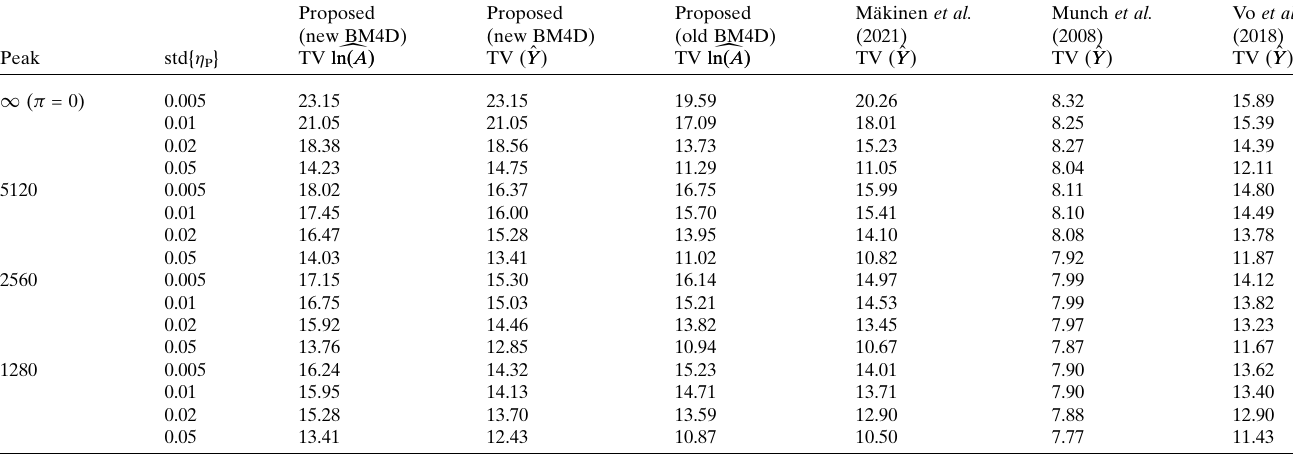
Table 2 Average SNR for the reconstructed volumes of the BrainWeb phantom for the set of experiments shown in Table 1. Each reconstruction is performed with TV, either on the estimate ^ YY of the streak-free projections Y (5), or the estimate d ln ð A Þ ln ð A Þ of the underlying stack of projections ln( A ) (4). Left-to-right: reconstructed volumes of estimates produced by the proposed full procedure with improved BM4D, proposed streak removal with improved BM4D, proposed full procedure with old BM4D, Ma¨kinen et al. (2021), Mu¨nch et al. (2009), and Vo et al. (2018). Each regularization parameter r of TVis optimized individually for best SNR for each realization and method. The SNR values are each computed against the ground-truth noise-free phantom.